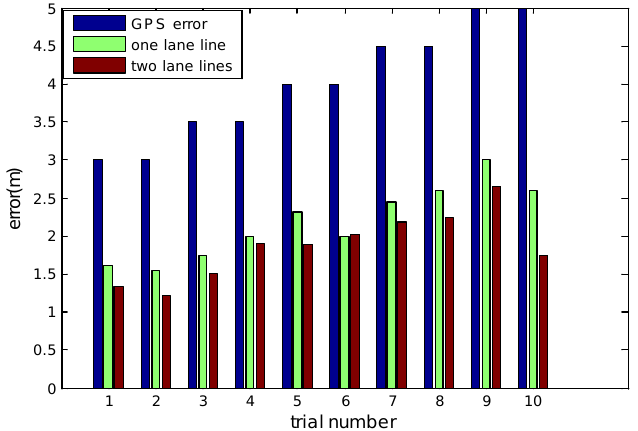
Figure 5. The errors of vehicle localization. Figure 5. T he errors of vehicle localization. Figure 5. T he errors of vehicle localization.